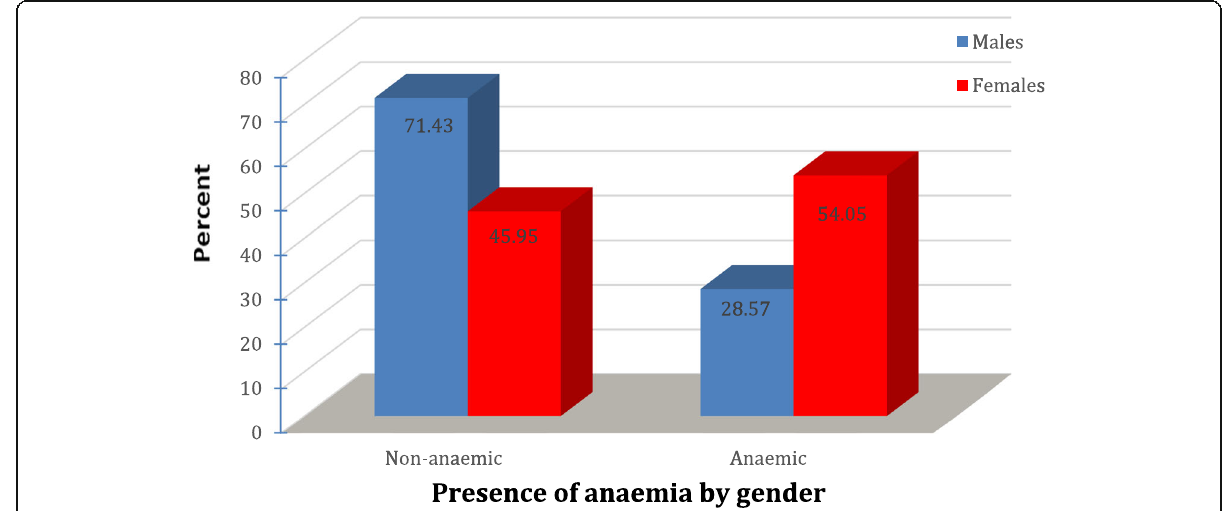
Fig. 3 Percent distribution of the studied multiple sclerosis patients at Kasr Al-Ainy Hospital by gender and presence of anemia (n =